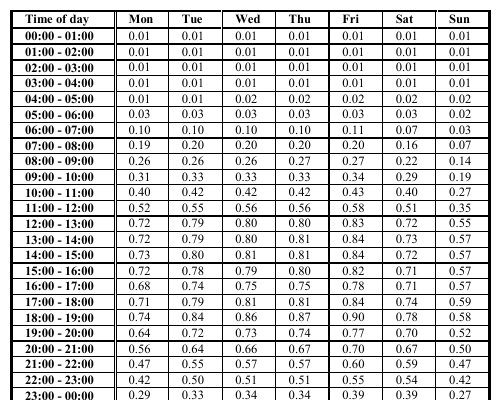
Table 1: Ratio of open POIs of the category food services Time of day